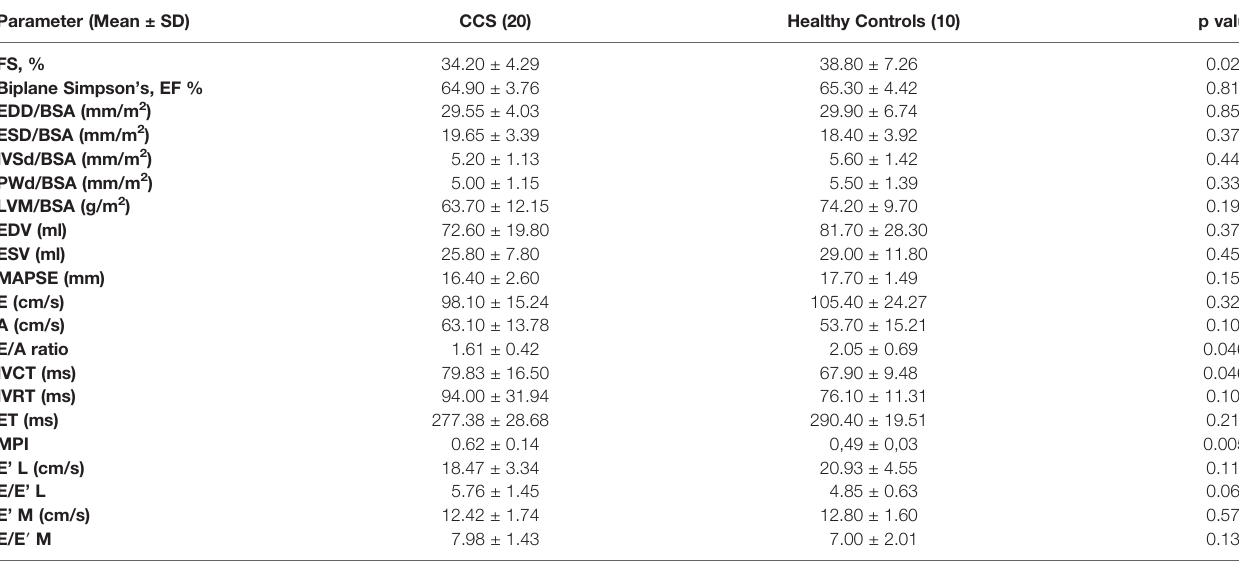
TABLE 3 | Conventional echocardiographic assessment.